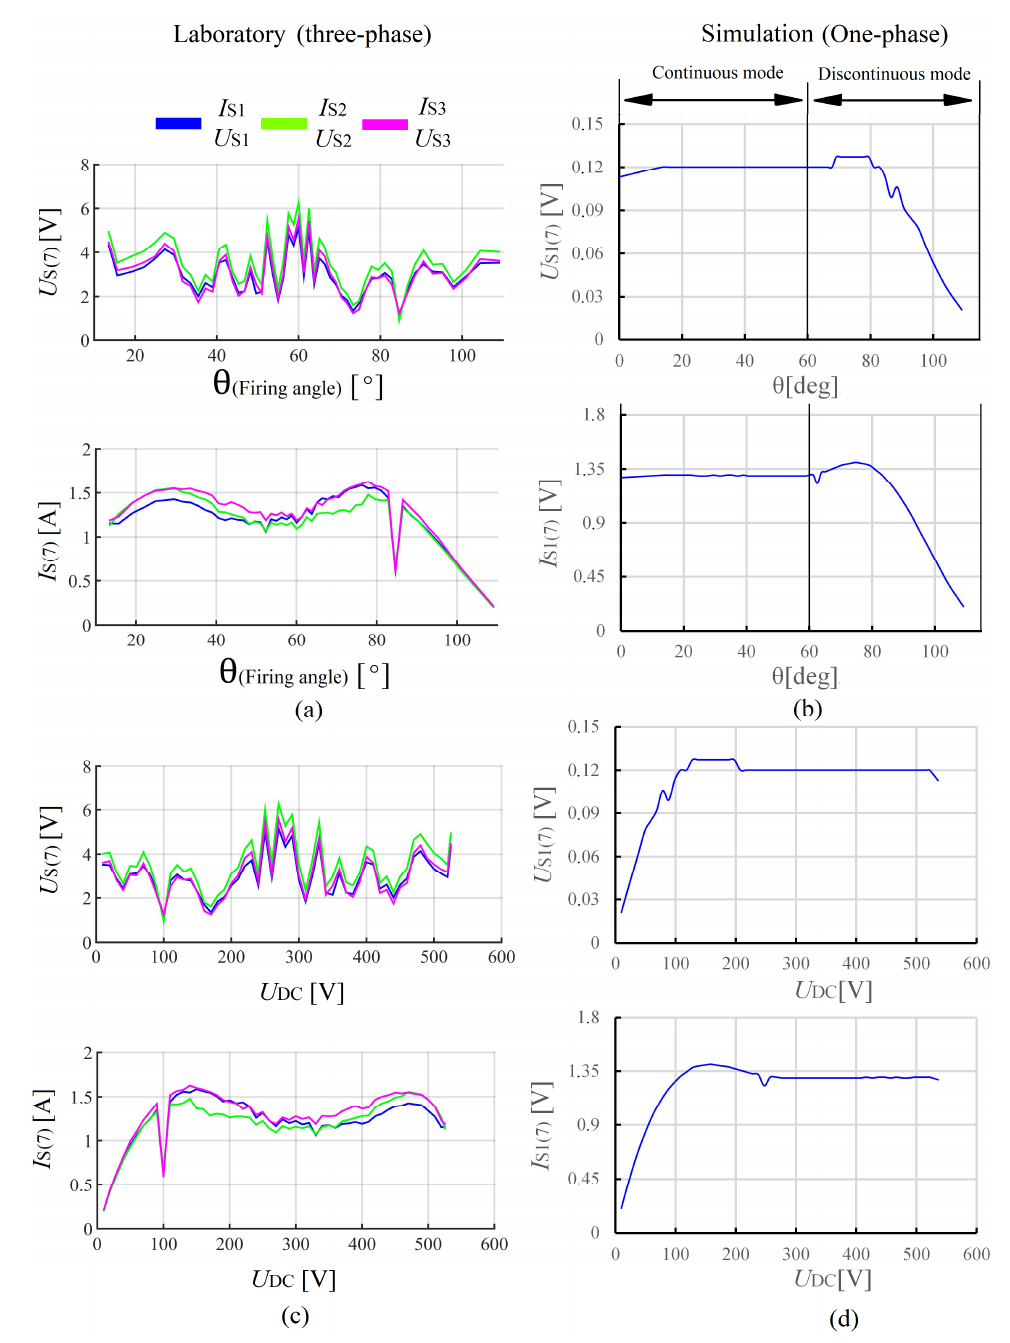
Figure 10. Comparison between the laboratory and simulated characteristics: PCC voltage and current 7th harmonic versus rectifier firing angle ( a , b ) and versus rectifier DC voltage ( c , d ). Figure 8a,b represent the voltage and current (fundamental harmonic) versus rectifier firing angle, and Figure 8c,d represent the voltage and current (fundamental harmonic) versus rectifier DC voltage. The difference observed between the simulated grid voltage and the laboratory grid voltage (Figure 8) is due to the fact that in the case of simulation, the supply grid voltage was not distorted (pure sinusoidal waveform before the load connec- tion), whereas, in the case of the laboratory, the supply grid voltage was already distorted before the load connection because of other devices which are continually connected and disconnected (the real electrical grid works